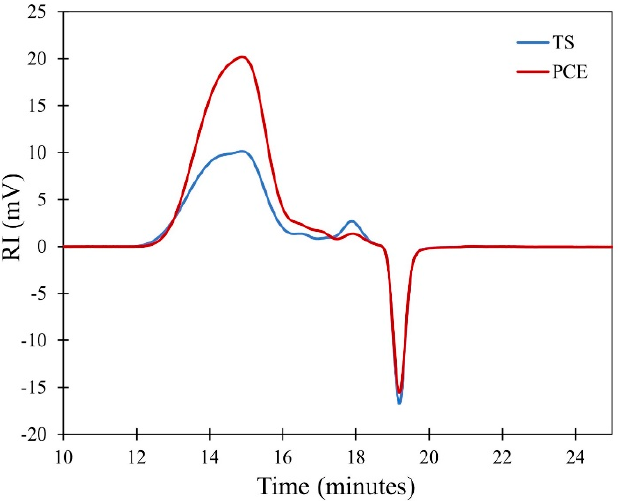
Figure A1. The results of GPC. Table 1. The molecular parameter of PCE polymer and TS